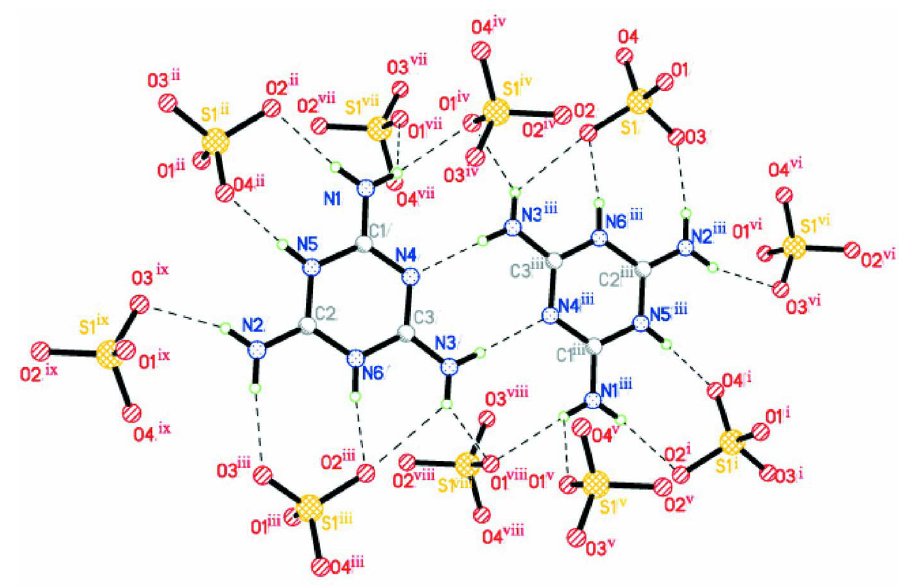
Diagram showing the hydrogen bonds of the melaminium cation. symmetry codes: (i) x , y + 1, z ; (ii) - x + 1, - y , - z +